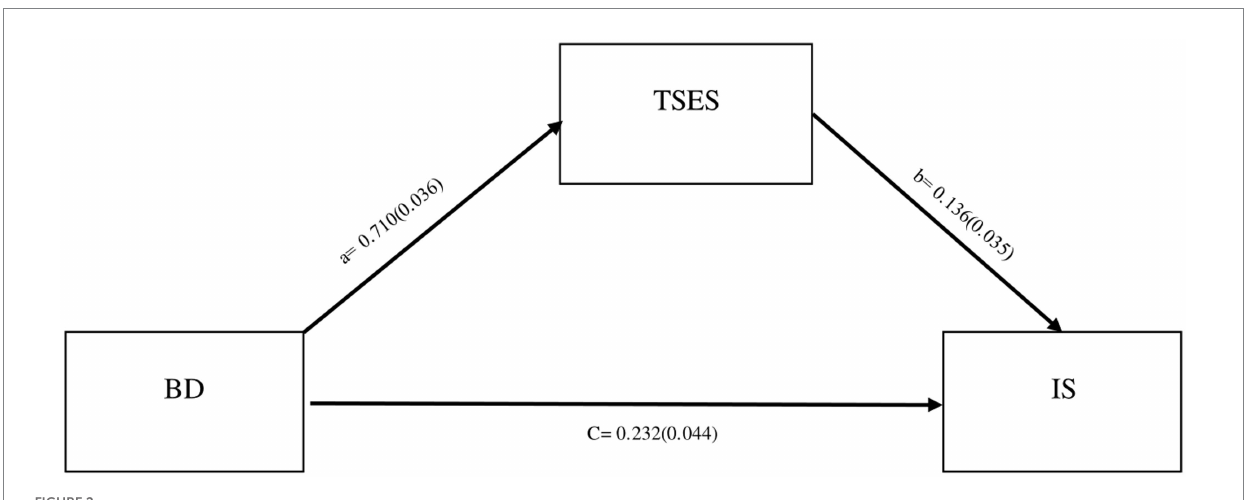
FIGURE 2 TSES mediated the relationship between BD and IS. TSES, Teacher’s sense of self-efficacy;BD, Behavioral disorders; IS, Inclusive setting.